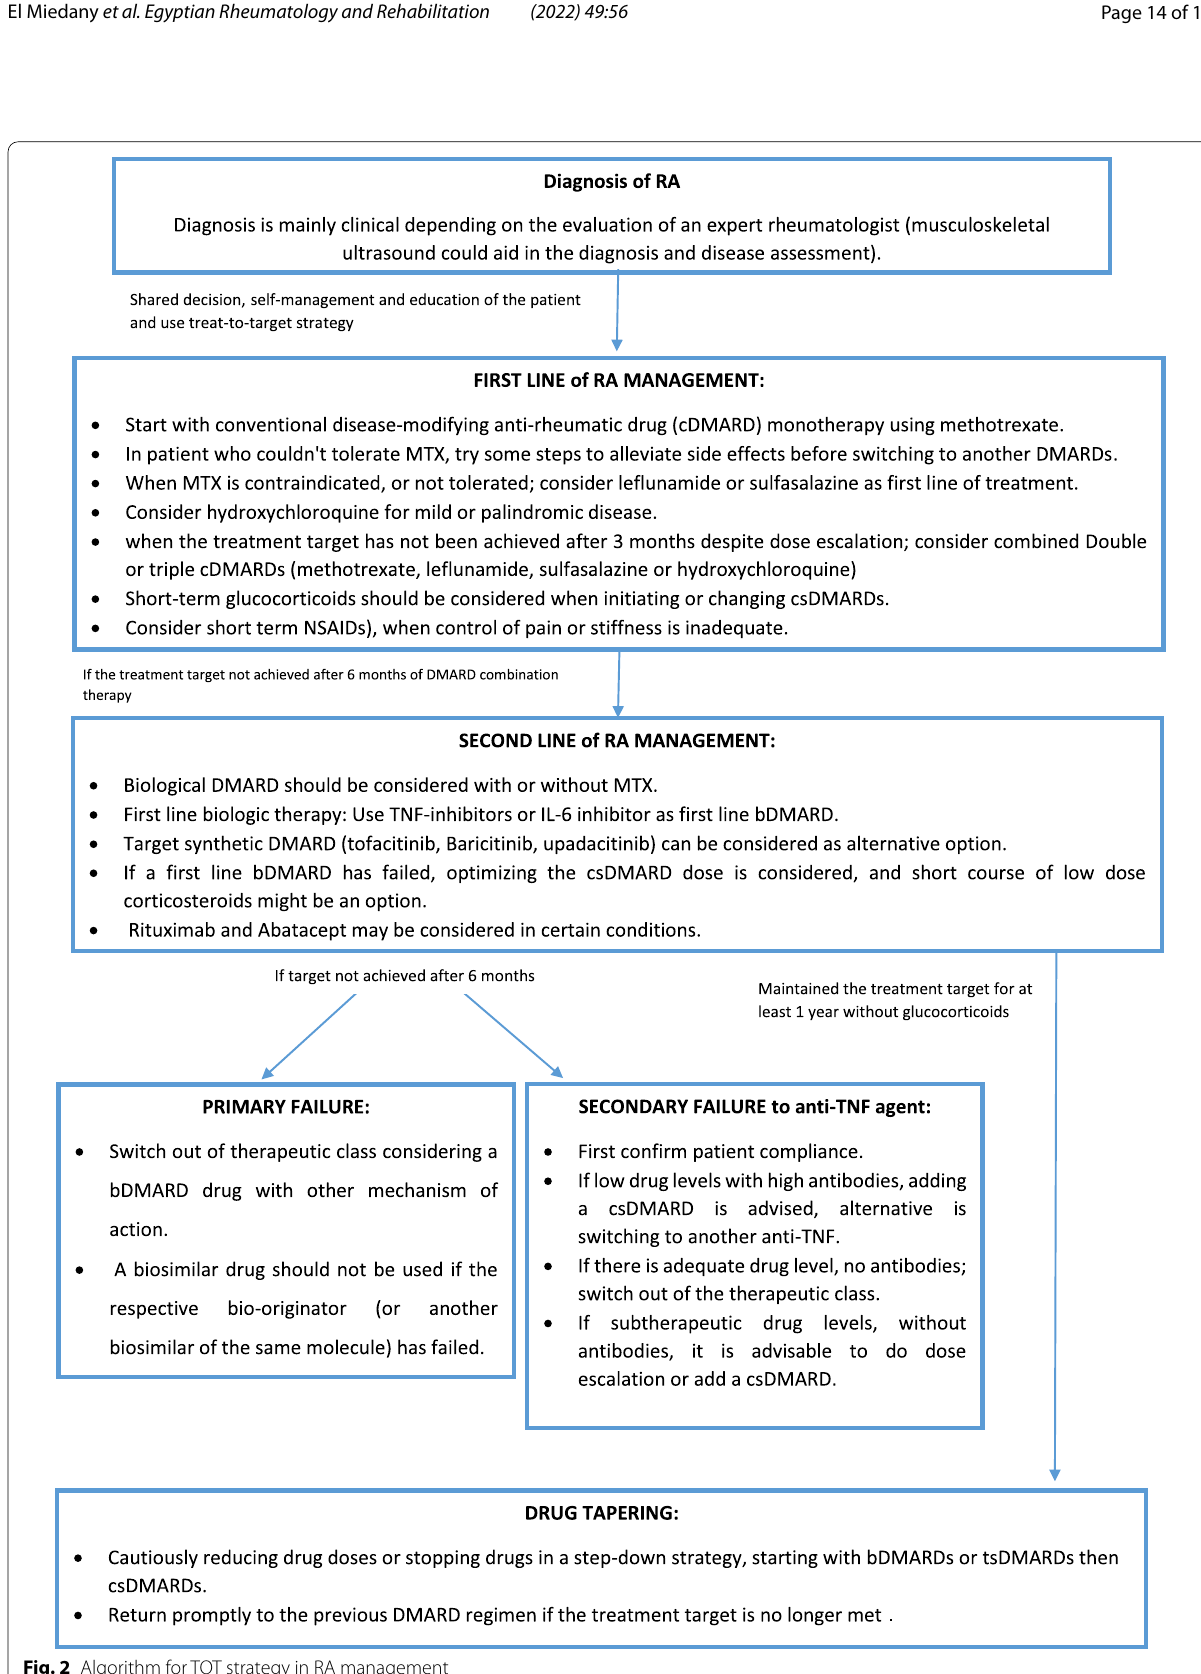
Fig. 2 Algorithm for TOT strategy in RA